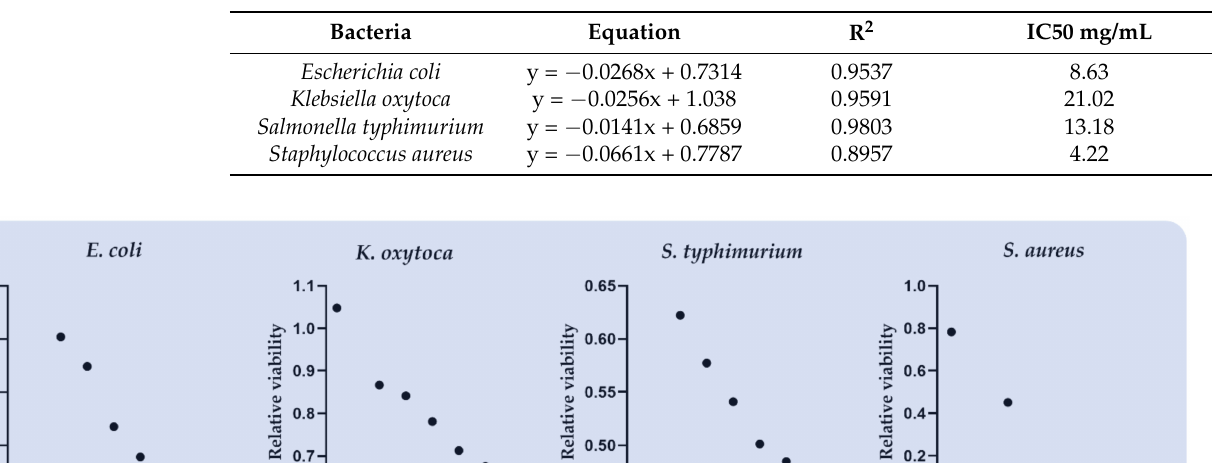
Table 5. IC50 in mg CCE extract/mL of MTT assay.